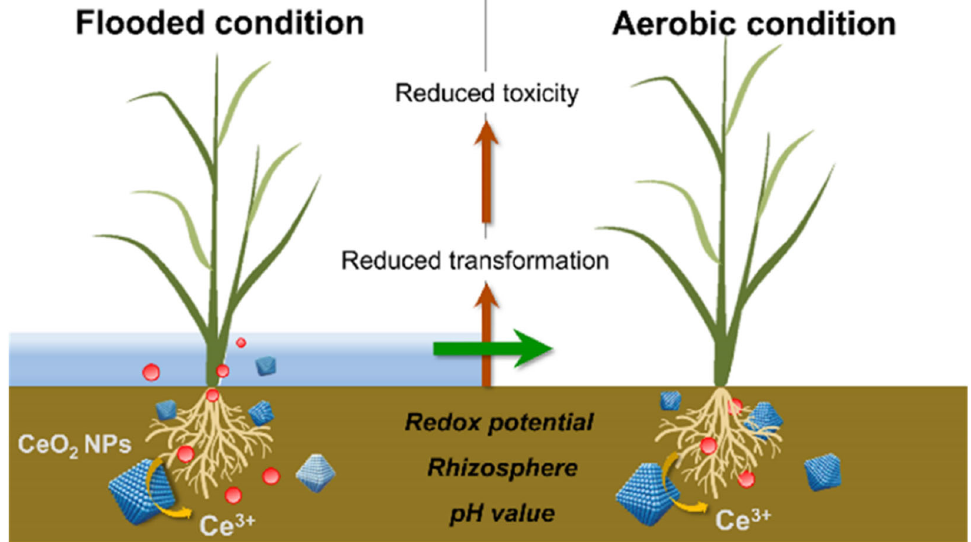
Figure 11. Nano-Fe 3 O 4 -modified biochar promotes Fe film formation and Cd fixation in rice roots. Reprinted with permission from Ref. [80]. 2021, American Chemical Society.